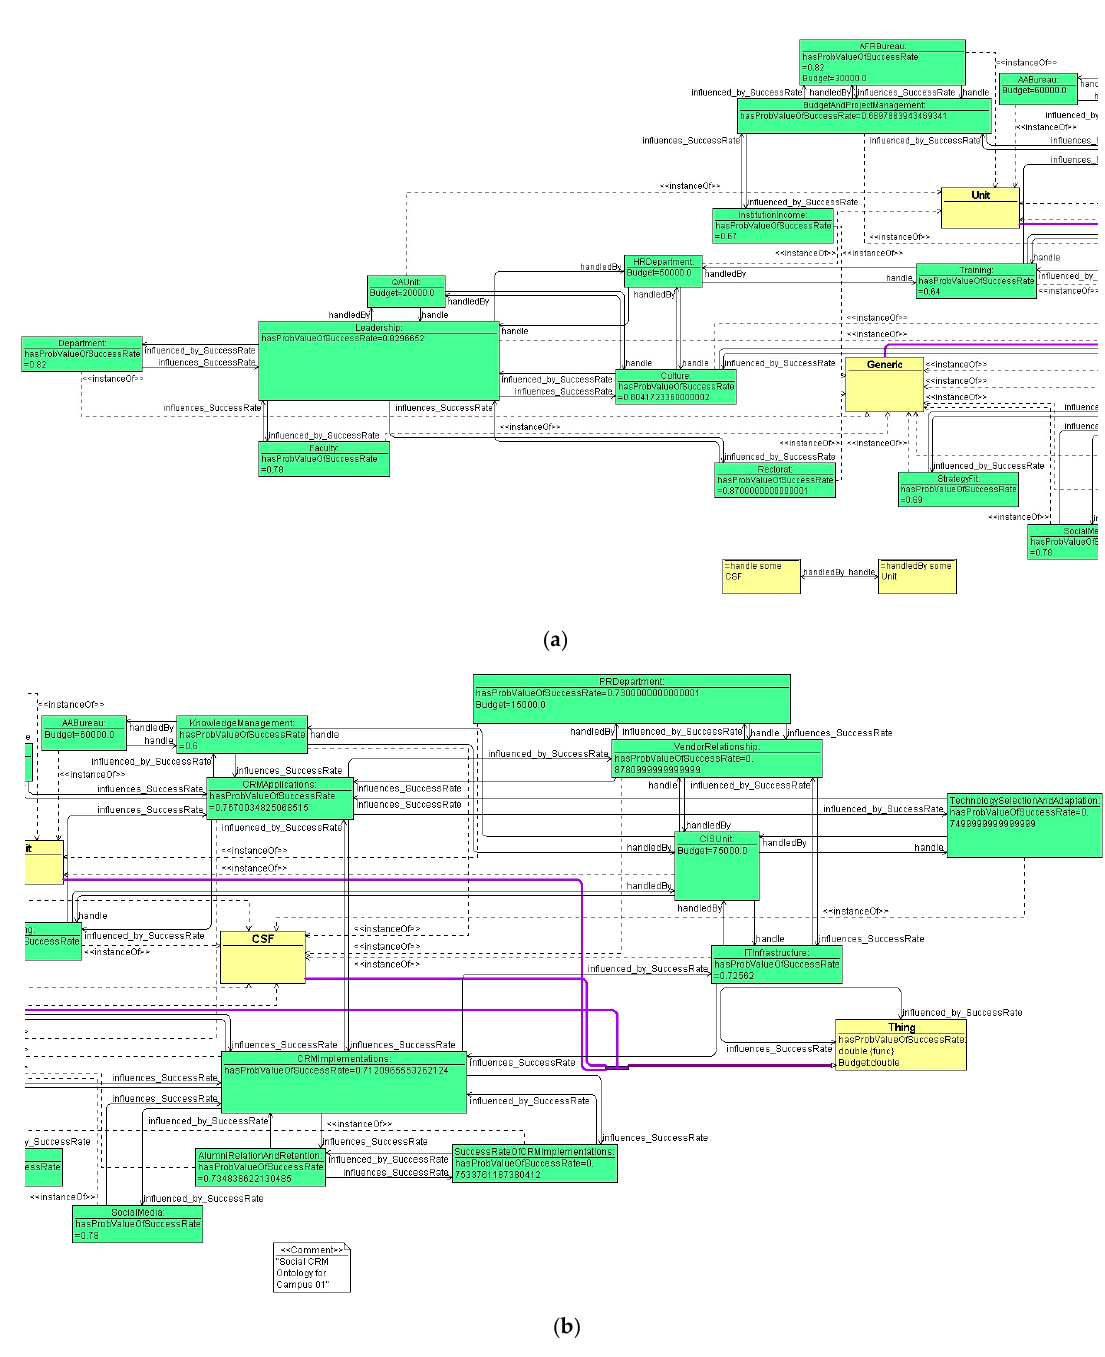
Figure 9. Social CRM: the result of running the program in the XDSL document.